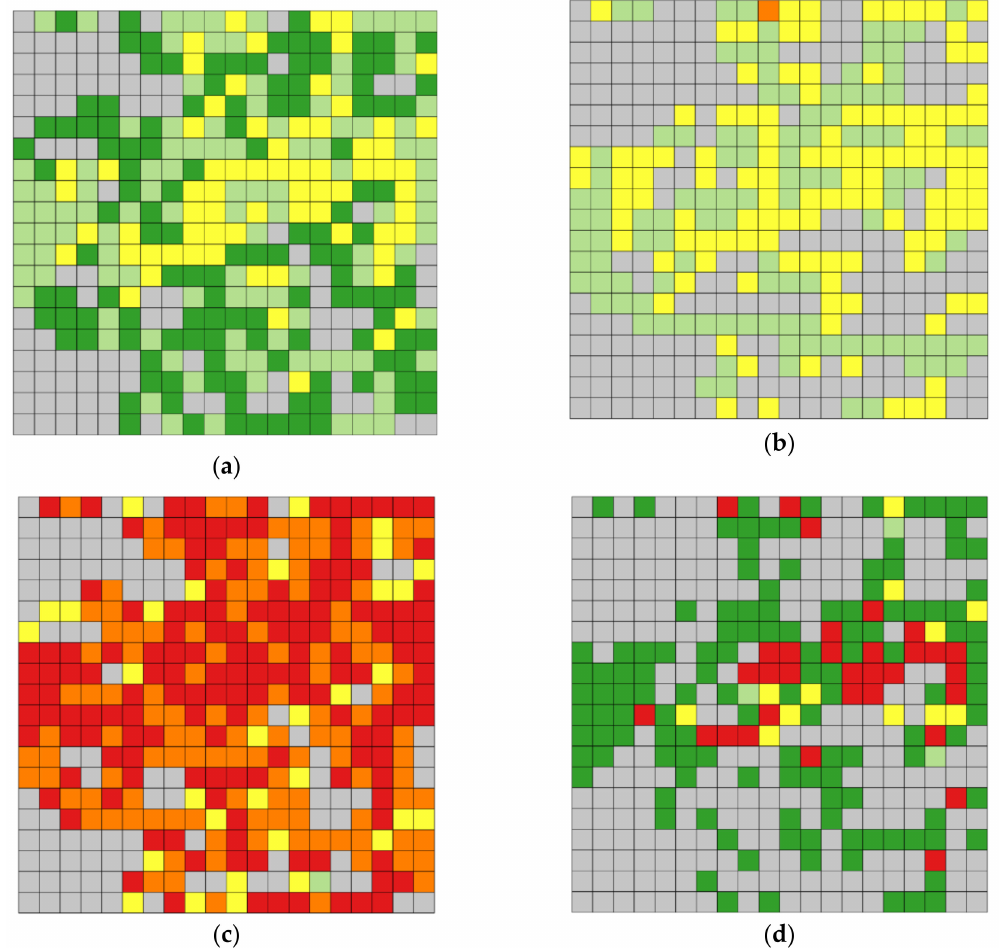
Figure 6. Level of connectivity for each basic field for k = 1 (100 m basic fields): ( a ) beta measure; ( b ) gamma measure; ( c ) eta measure; ( d ) four-way intersection